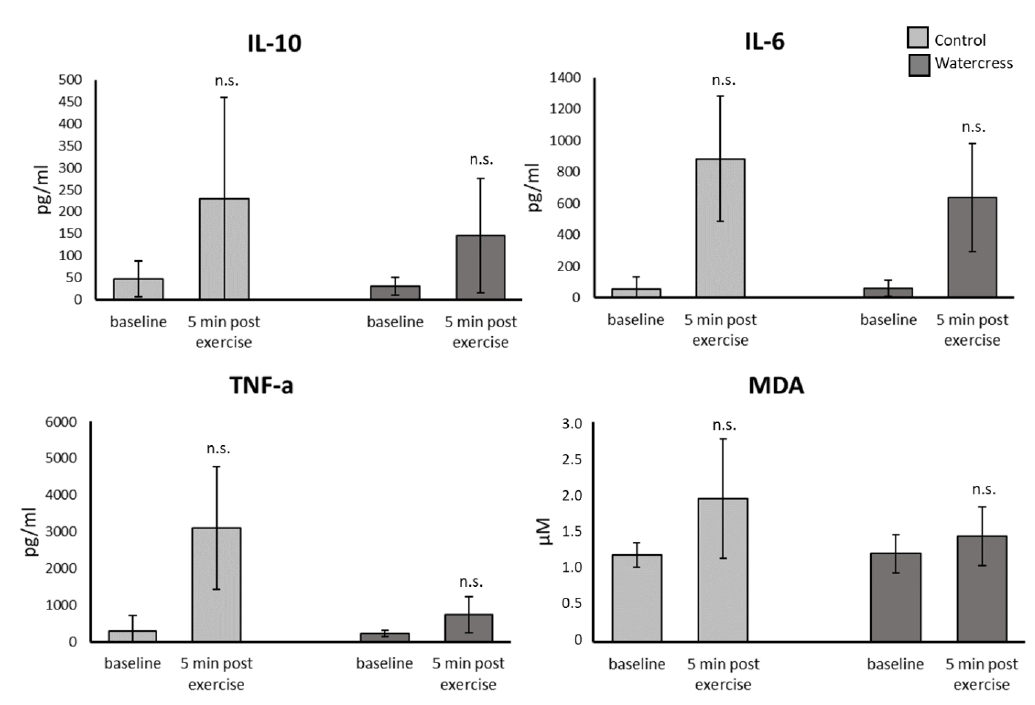
Fig. 3: Effect of acute watercress consumption on blood markers of inflammation (IL-10, IL-6, TNFα) and oxidative stress/lipid peroxidation (MDA) after high-intensity training in untrained subjects (n=4). MDA levels were measured in heparin plasma. Inflammatory cytokines were measured in ex vivo LPS-stimulated whole blood cultures.